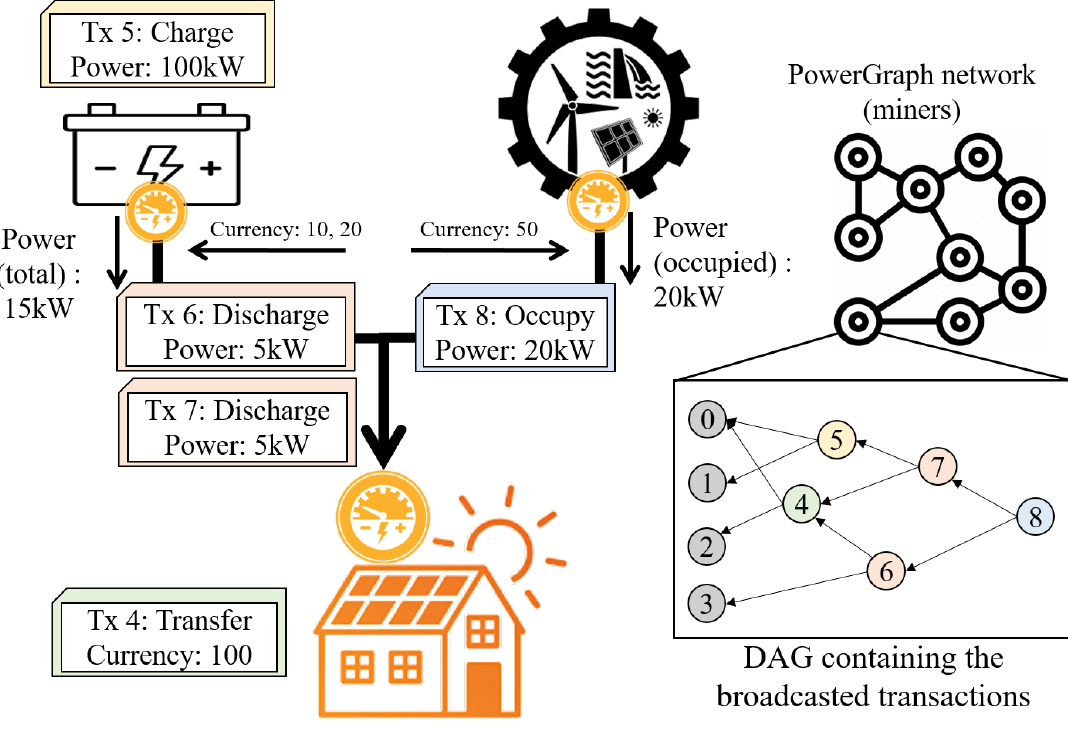
Figure 3. PowerGraph sample